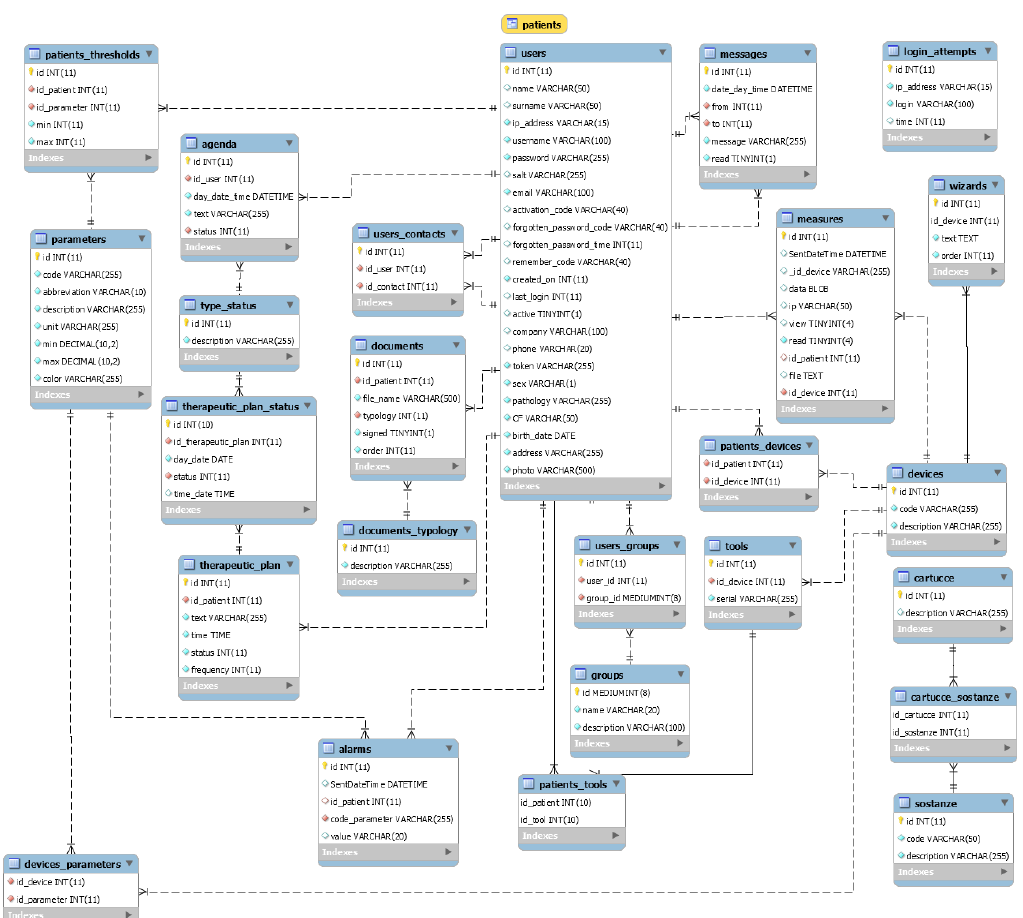
Figure A1. Database structure of the information system oriented on homecare assistance monitoring and integrating LSTM algorithms.